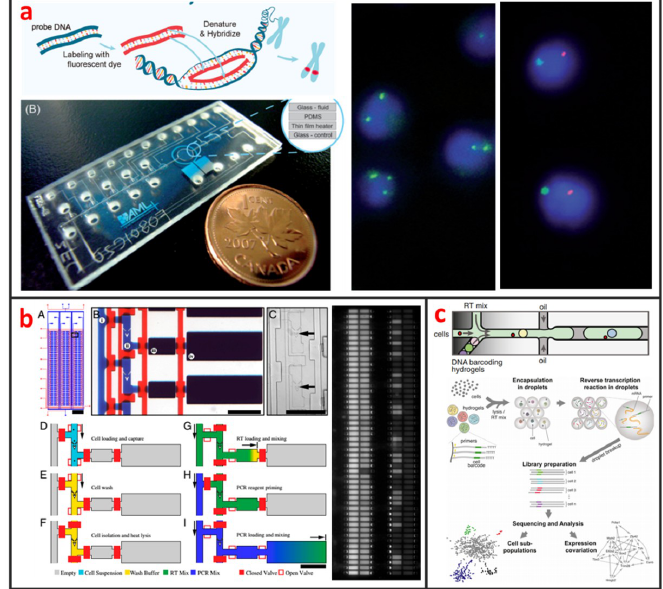
Figure 9. Genetic analysis of single-cells by using microfluidics. ( a ) An integrated microfluidic chip for chromosome enumeration using FISH. Adapted by permission from Reference [109], copyright Royal Society of Chemistry 2008. ( b ) High-throughput microfluidic single-cell RT-qPCR for gene expression analysis. Adapted by permission from Reference [110], copyright National Academy Sciences 2011. ( c ) Capturing single-cells along with a set of uniquely barcoded primers in microfluidic chip generated tiny droplets enables single-cell transcriptomics of many cells in a heterogeneous population. Adapted by permission from Reference [30], copyright Elsevier Inc. 2015.